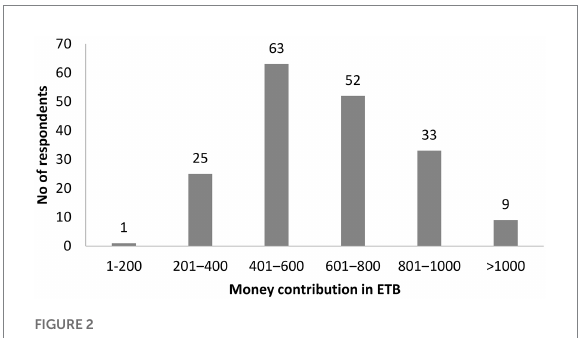
FIGURE 2 Respondents’ annual maximum willingness to pay for improving Lake Tana ecosystem services (One US$ = 43.5 Ethiopian Birr (ETB) on June 19, 2021 (Source: https://www.Combanketh.et/en/